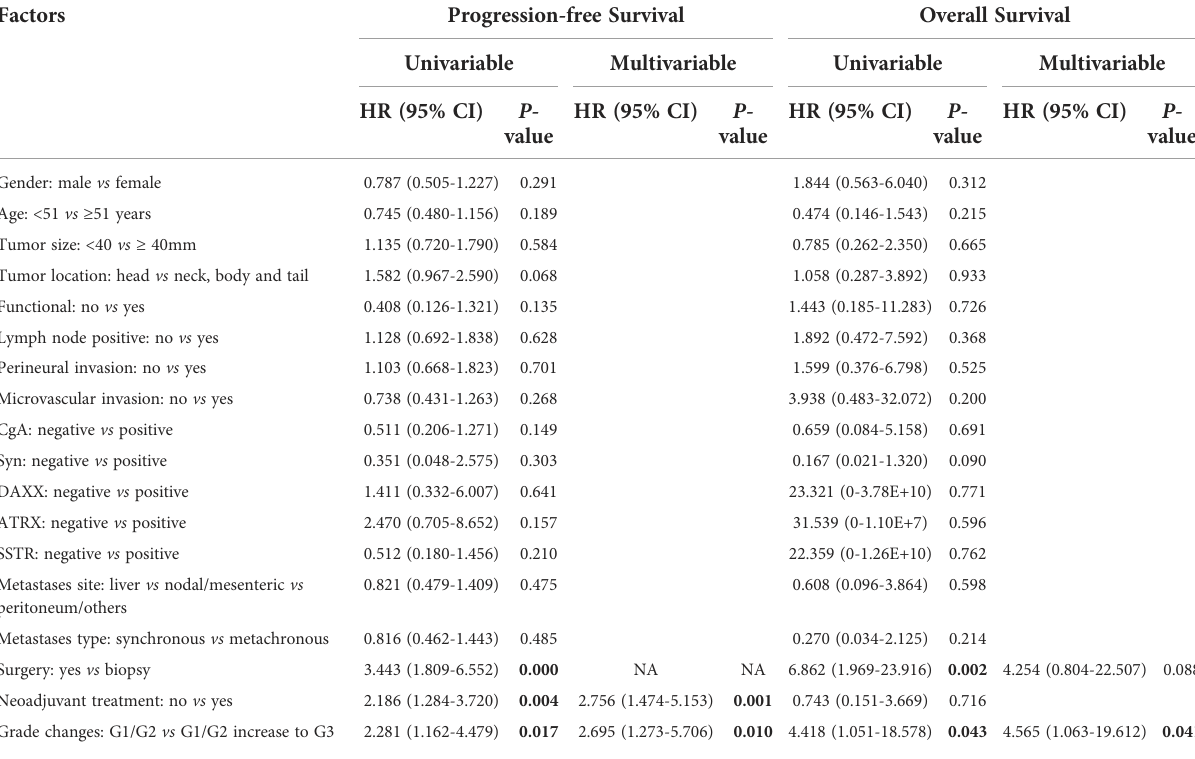
Table 3. Univariable and multivariable analysis of factors for progression-free survival and overall survival in the study cohort.